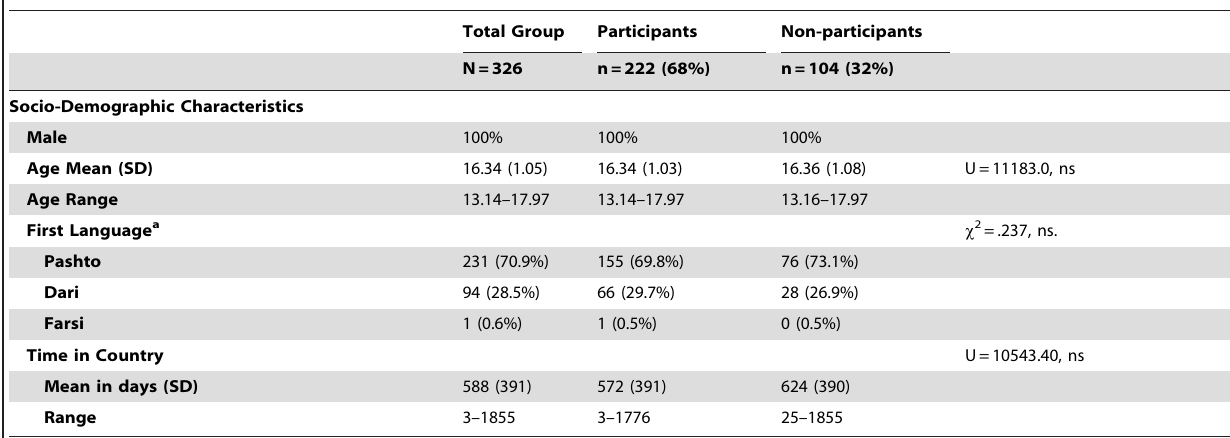
Table 1. Demographic statistics of the sample.